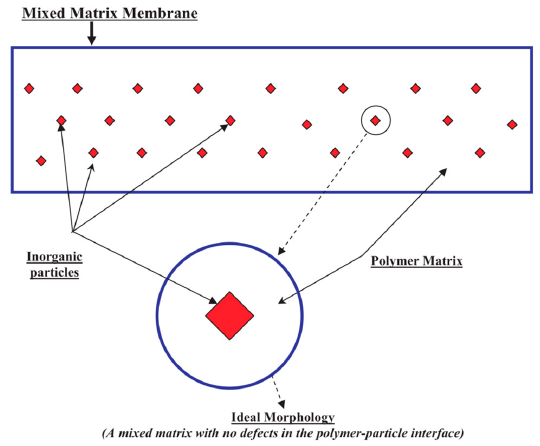
Figure 2. Schematic diagram of ideal MMM structure. Reproduced with permission from Ref. [77] Copyright 2010 Elsevier.